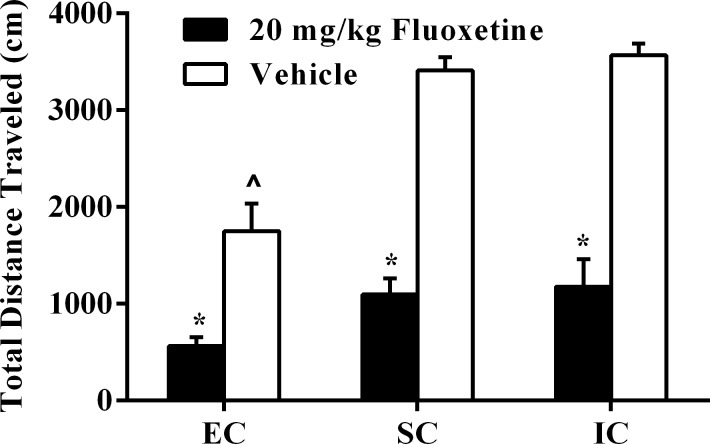
Experiment II Locomotor Activity Following 20 mg/kg Fluoxetine.Experiment II total locomotor distance (cm) traveled (±SEM) in EC, SC, and IC rats after subchronic fluoxetine (20 mg/kg, i.p.) or vehicle administrations 23.5 hrs, 5 hrs, and 1 hr before the locomotor test. Asterisks (*) indicate significant reductions in locomotor activity in fluoxetine-treated rats compared to vehicle controls for all three environmental conditions. Caret sign (^) indicates significant reductions in locomotor activity in EC-vehicle rats compared to both SC- and IC-vehicle rats (p < .05).